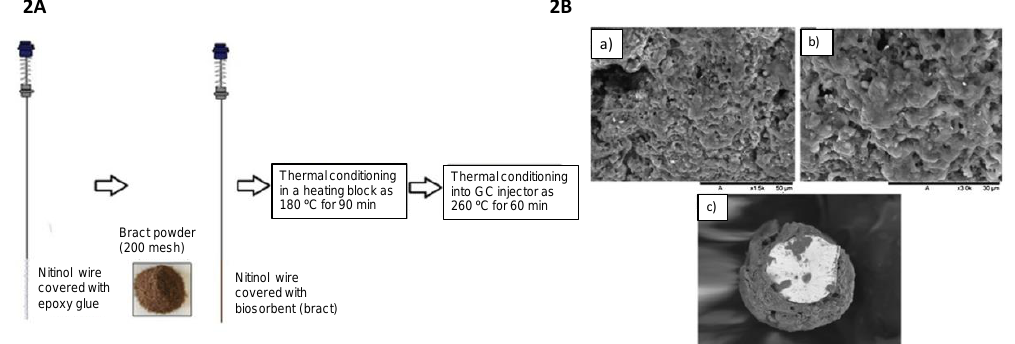
Figure 2. ( 2A ) Scheme of the preparation of SPME fibers and ( 2B ) SEM micrographs obtained for bract fiber ( a ) magnification of 1500× ( b ) magnification of 3000× and ( c ) a cross-section of the proposed fiber at magnification of 300×. Reproduced with permission from [20], Copyright Elsevier, 2017.